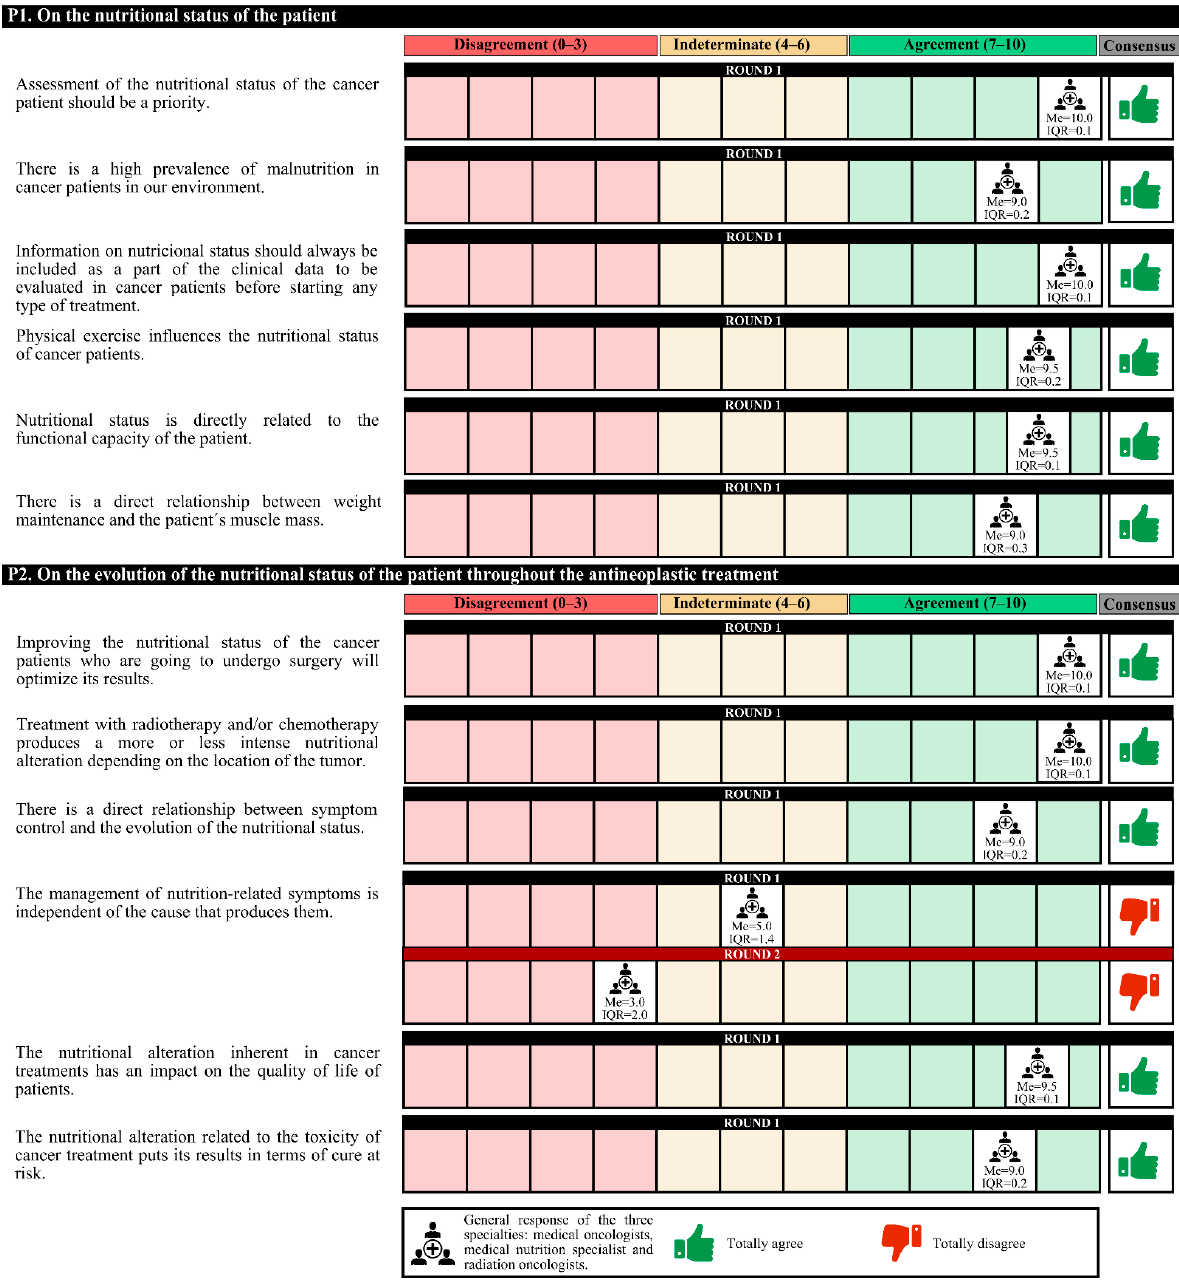
Figure 1. Answers about nutritional status. IQR, interquartile range; Me, median.